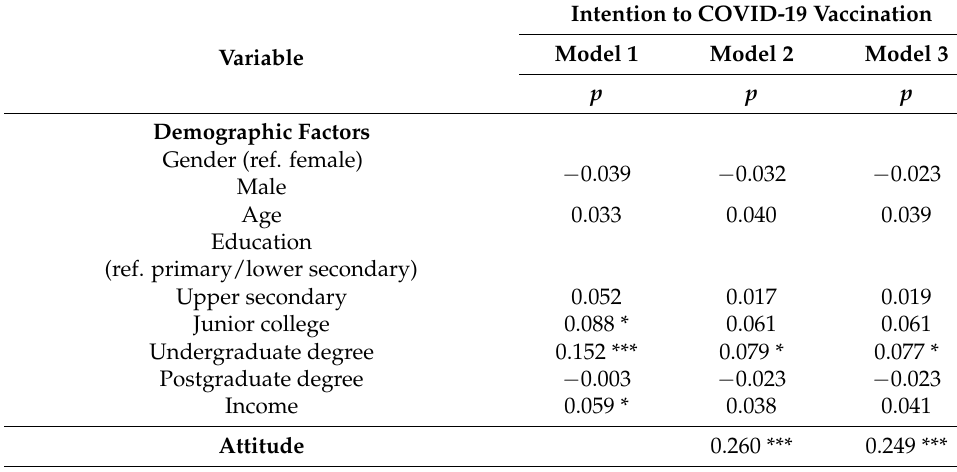
Table 5. Hierarchical regression model of factors associated with intention to receive COVID-19 vaccines ( n =